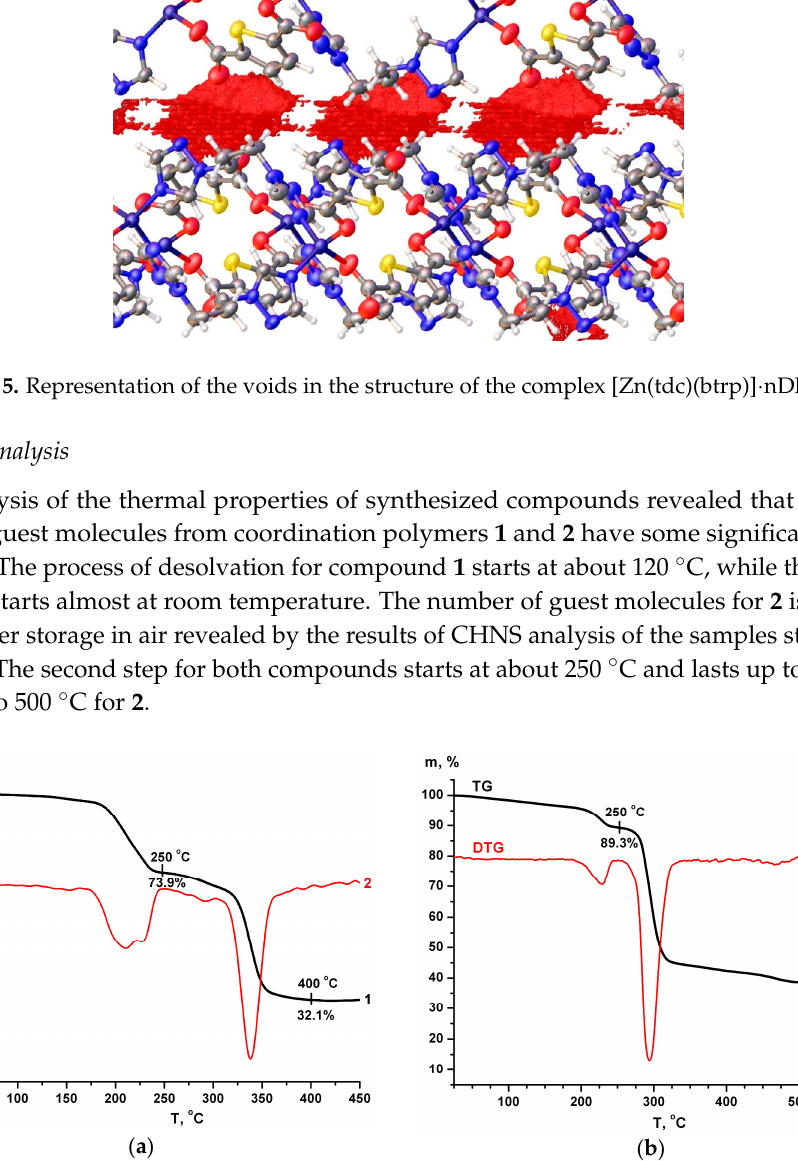
Figure 6. Curves of thermal analysis for compound 1 ( a ) and for compound 2 ( b ).